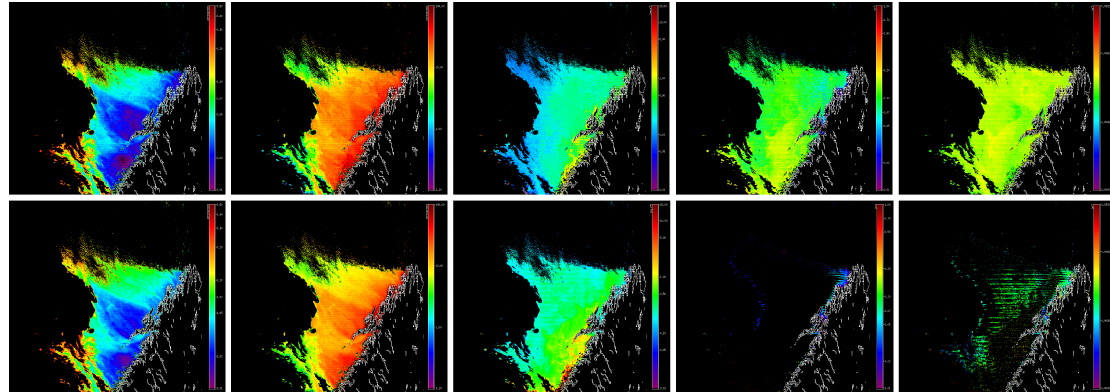
Figure 7. MODIS image comparison between OC-SMART ( top ) and standard SeaDAS ( bottom ) retrievals on 18 April 2014 over a Norwegian coastal area [107]. From left to right: τ 869 , f, CHL, CDOM and b bp ,